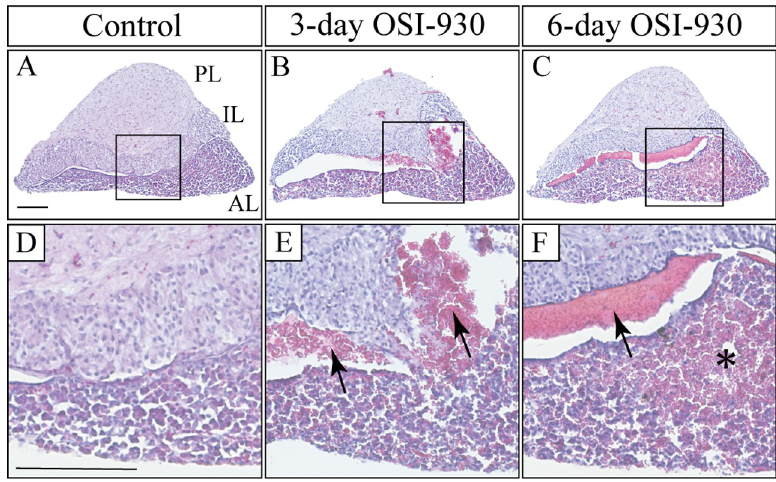
Fig 1. OSI-930 causes pituitary apoplexy around Rathke’s cleft. H&E stained sagittal images of pituitary glands in control (A and D), three-day OSI-930-treated (B and E), and six-day OSI-930-treated (C and F) groups. Boxed regions in A-C are enlarged in D-F, respectively. In three-day OSI-930-treated group, hemorrhage occurred around Rathke’s cleft (arrows; E). In six-day OSI-930-treated group, hemorrhage was exacerbated around Rathke’s cleft (asterisk; F), and many small bleeds were observed throughout the anterior lobe (C and F). Bars, 200 μ m. AL, anterior lobe; IL, intermediate lobe; PL, posterior lobe.